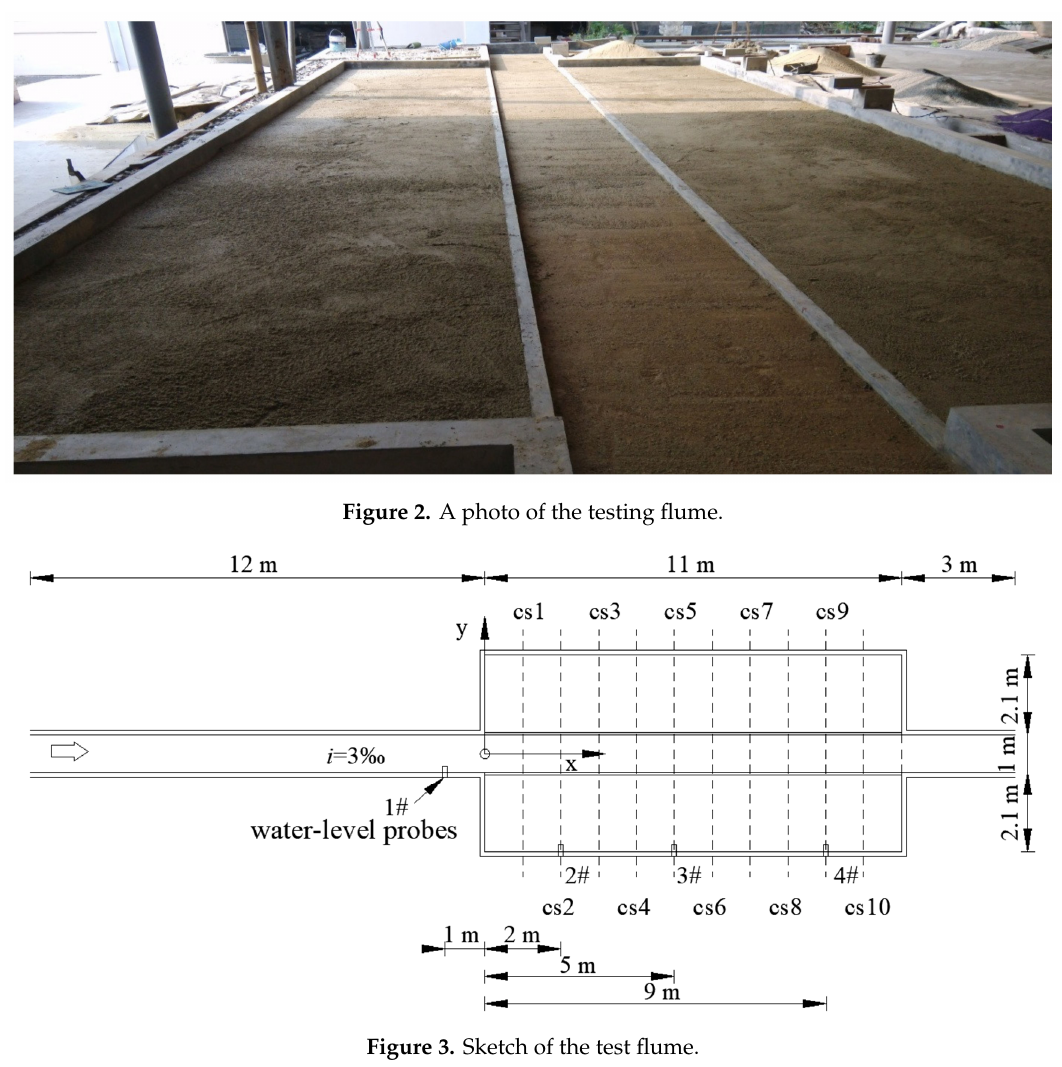
Figure 3. Sketch of the test flume.